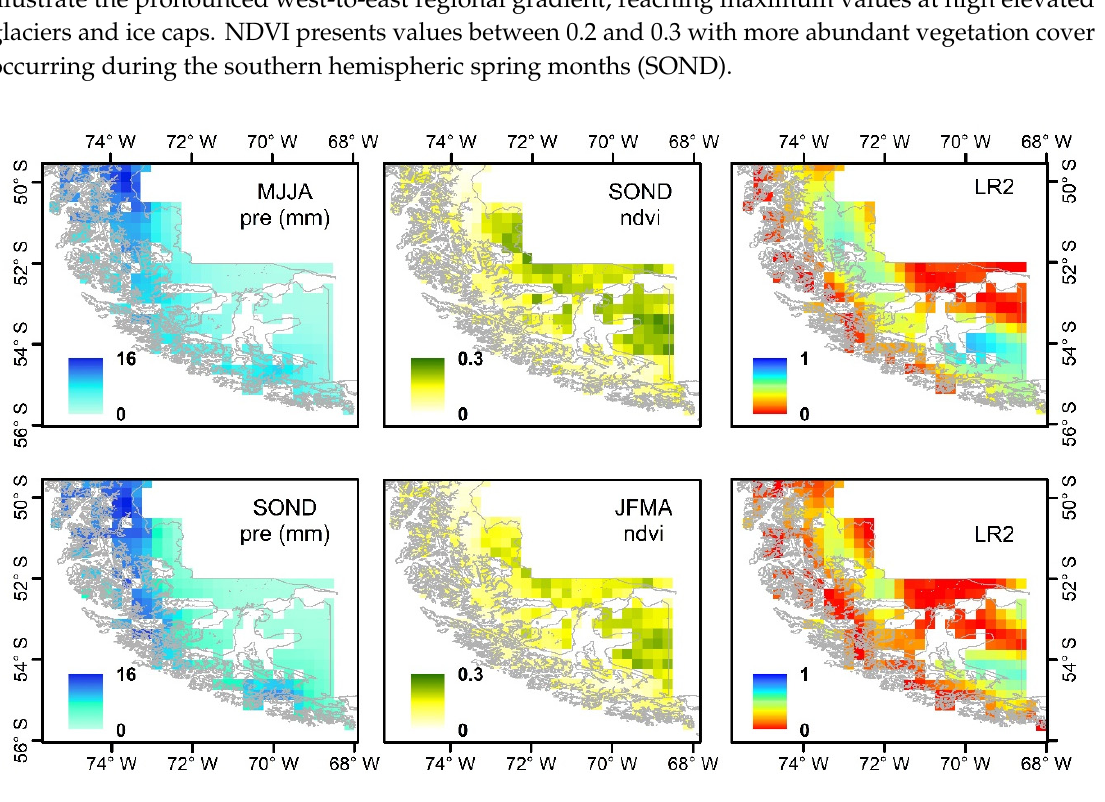
Figure 3. Spatial patterns of precipitation (left-hand plots), NDVI (center plots) and explained variance of the regression between precipitation and NDVI values from 1985–2018 (right-hand plots). JFMA = January to April, MJJA = May to August, SOND = September to December, LR2 = local squared regression coefficient.